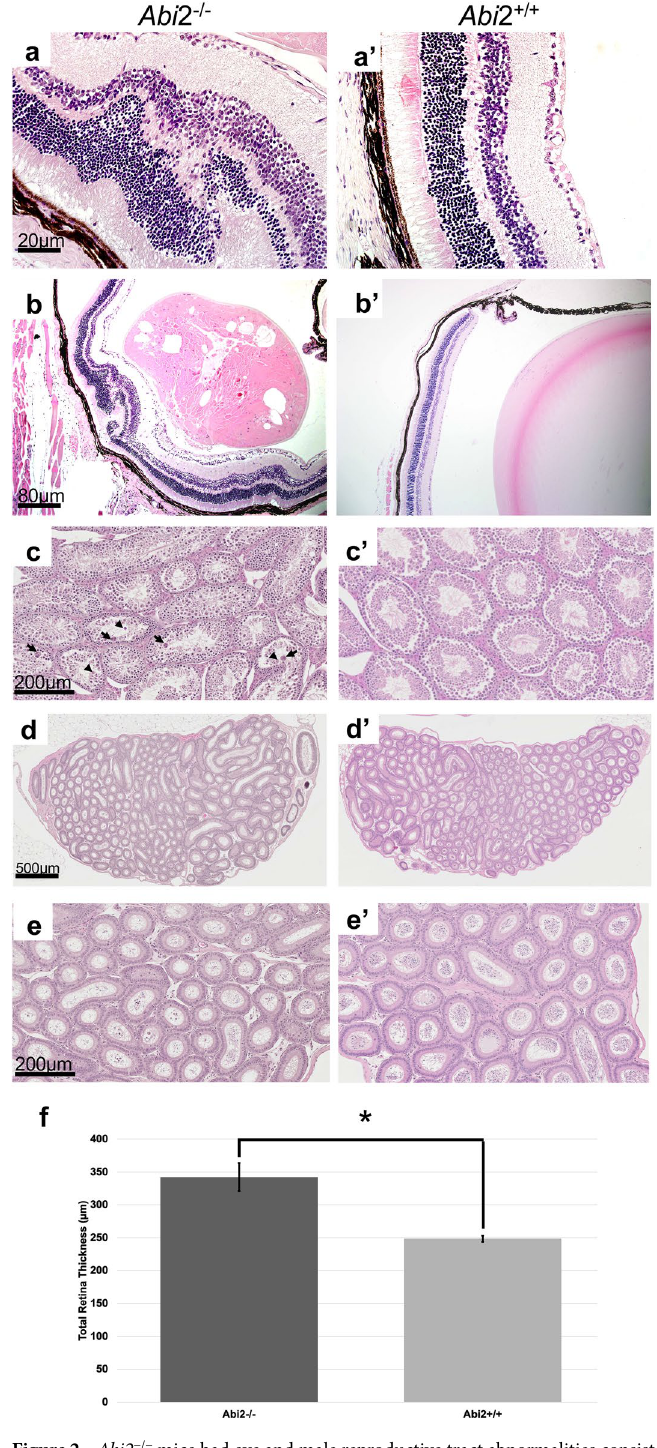
Figure 2. Abi2 −/− mice had eye and male reproductive tract abnormalities consistent with ciliopathy compared to controls. ( a ) Marked, chronic, multifocal localized retinal dysplasia characterized by multiple clusters of external nuclear structures within the outer plexiform layer. ( b ) Cortical cataract is present with marked, chronic, focally extensive swollen and disrupted lens fibers with abnormally retained nuclei (balloon cells) with capsular thickening and wrinkling in the cortical region of the lens. ( c ) 20 × magnification histopathology showed testicular degeneration, marked, chronic, bilateral, multifocal vacuolation of the seminiferous tubule epithelia with primary and secondary spermatocyte and spermatid hypocellularity, with very few spermatozoa. Apoptotic bodies (arrowheads) and multinucleated giant cells (arrows) were frequent. ( d ) On magnification (5 ×), the epididymis showed marked hypospermia. Epididymal ducts in all segments of the epididymis (caput, corpus, cauda) contained cell and protein debris in the lumen with few mature spermatozoa. ( e ) Magnification (20 ×) of ( d ). ( f ) Quantitative measurement of average total retina thickness, where Abi2 + / + n = 12, average = 342.35 µm, SE = 4.88 and Abi2 −/− n = 9, average = 342.35 µm, SE = 21.35 p -value = 0.0190. All error bars represent standard error of the mean, * indicates p -value < .05 result of student’s two-tailed